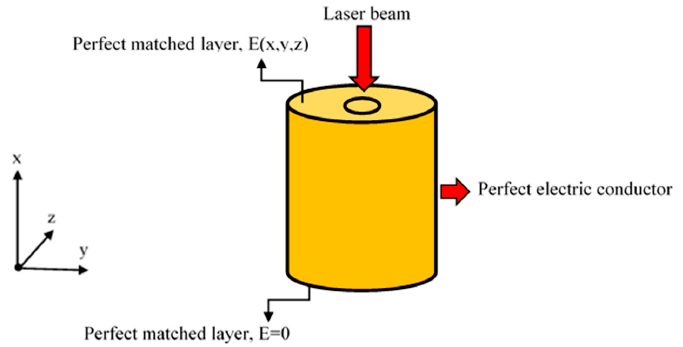
Figure 4. Schematic illustration of the model geometry and boundary conditions.